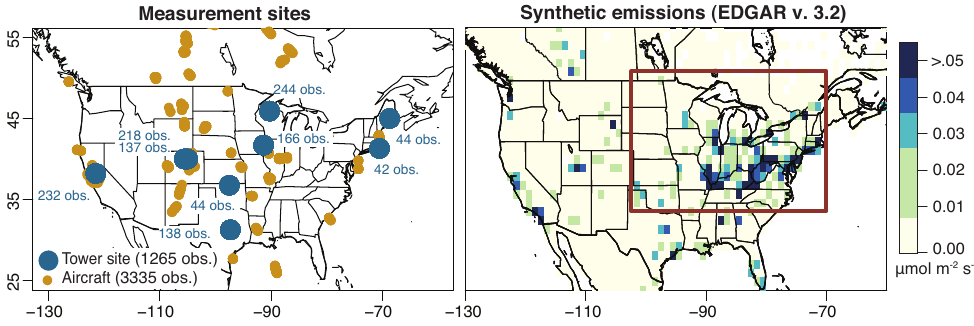
Fig. 1. The synthetic measurements and synthetic emissions used in this study. Blue numbers (left) indicate the observation count at each tower site. The red box (right) displays the region represented in Table 2. Table 2. Eastern US/Canada anthropogenic budgets and 95% confidence intervals (TgCmonth − 1 ) for the true synthetic emissions and inversion